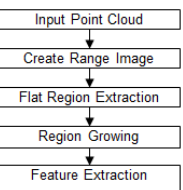
Figure 2. Flow chart of Point Cloud processing